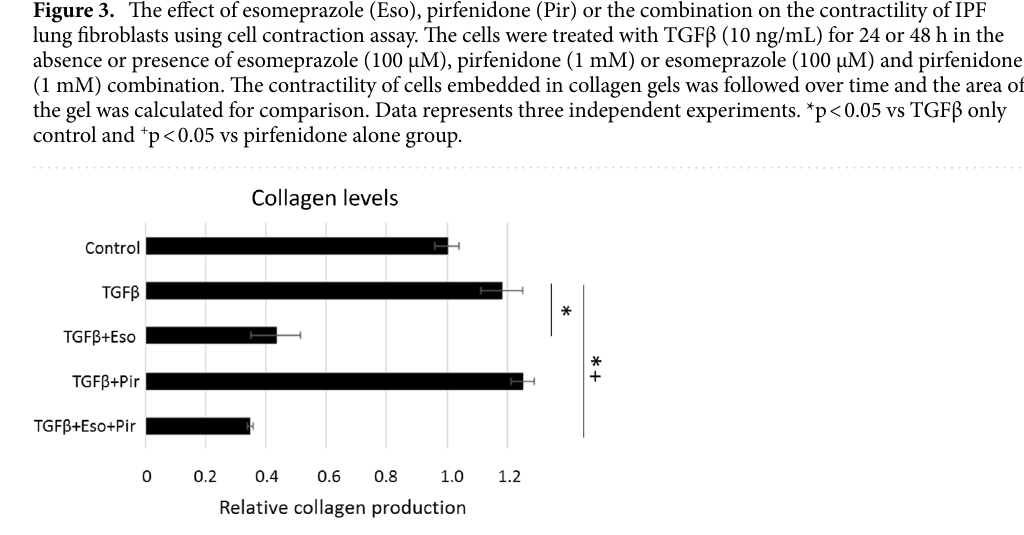
Figure 4. Sircol assay data showing the effect of esomeprazole, pirfenidone or the combination on the production of soluble collagen. Human IPF lung fibroblasts were treated with TGFβ (10 ng/mL) in the absence or presence of esomeprazole (100 µM), pirfenidone (1 mM) or esomeprazole (100 µM) and pirfenidone (1 mM) combination for 24 h. The amount of collagen, proportional to the intensity of red color, was assessed spectrophotometrically by measuring absorbance at 555 nm. Data is Mean ± SEM from triplicate experiments and represents three independent experiments. *p < 0.05 compared to TGFβ only control and + p < 0.05 vs pirfenidone alone